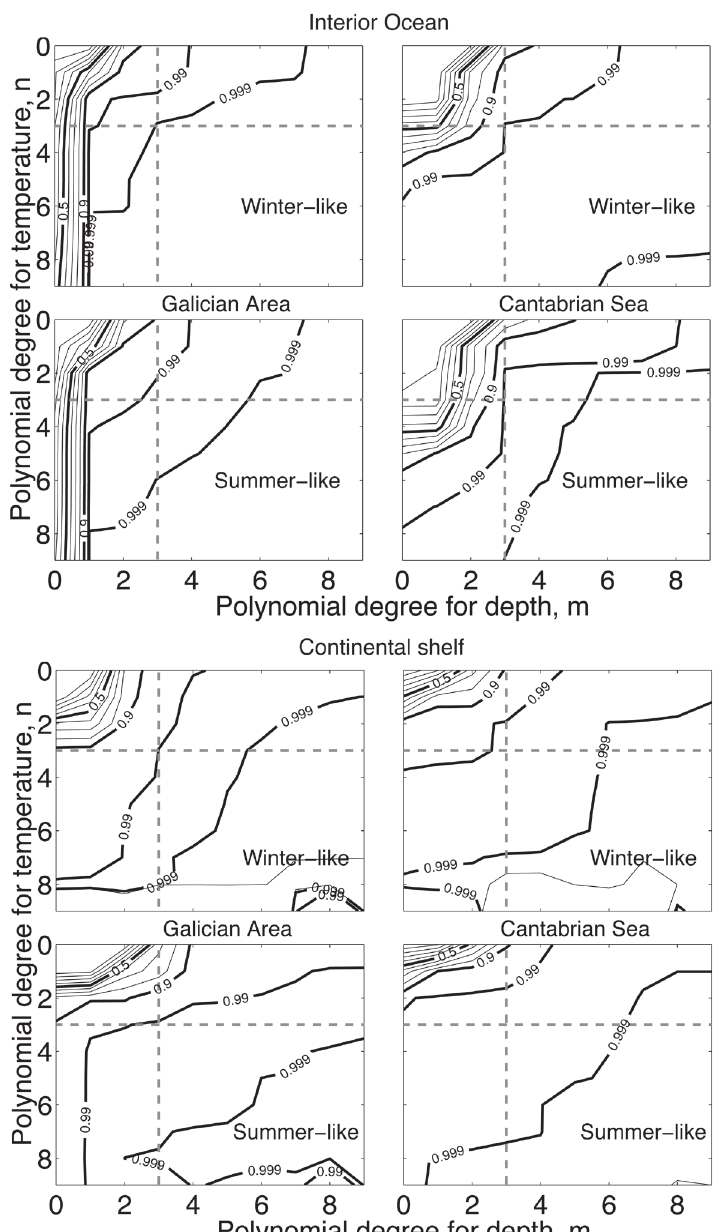
Fig . 8. – Upper: R2a contour lines for Galician Area and Cantabrian Sea corresponding to the winter-like and summer-like seasons in the interior ocean, as a function of polynomial degrees. Lower: same as before, but on the continental shelf. Gray dashed lines indicate the degrees of the polynomial fit finally